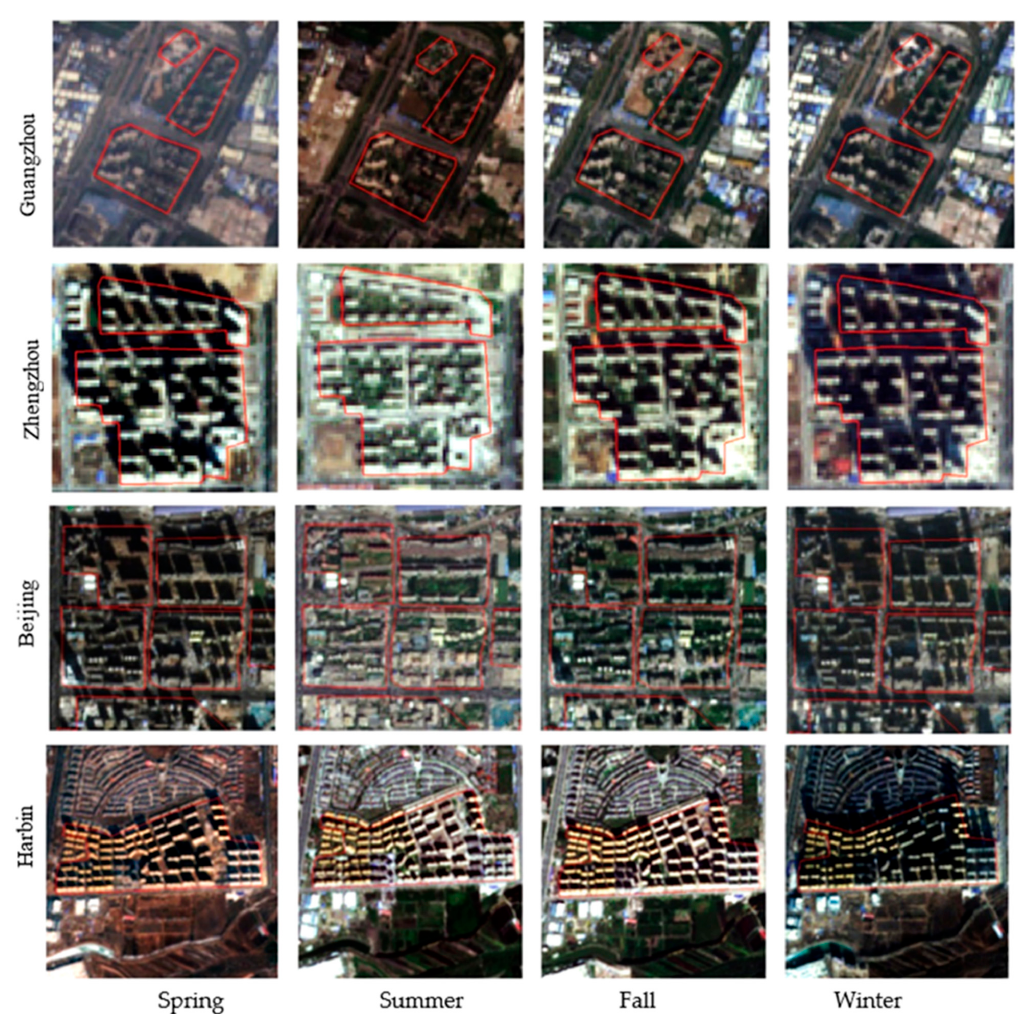
Figure 3. True-color images of patches selected from four cities and four seasons, and red rectangles refer to HRBs in the patches.